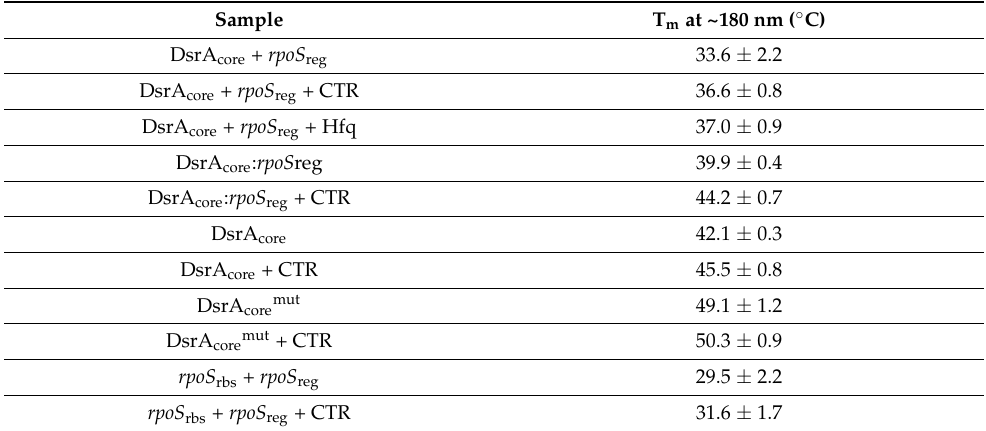
Table 1. Melting point (T m ) of RNA measured at 180 nm. DsrA core + rpoS reg means not prehybrided, DsrA core : rpoS reg means prehybrided by heat and cooling (see methods).